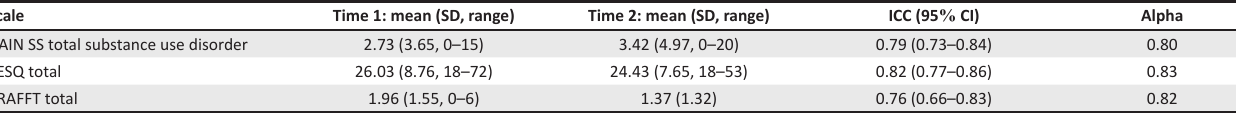
TABLE 2: Reliability of the GAIN-SS, PESQ and CRAFFT. Scale Time 1: mean (SD, range) Time 2: mean (SD, range)